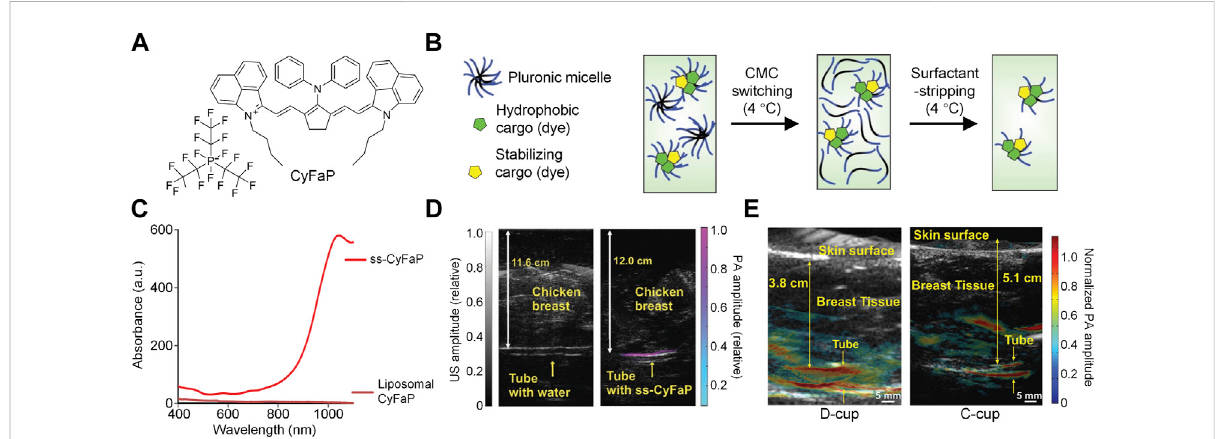
FIGURE 2 (A) Chemical structure of CyFaP. (B) Schematic illustration of preparation of surfactant-stripped micelles. (C) Absorption spectra of ss-CyFaP andLiposomal CyFaP. (D) PA overlaid with ultrasound images oftube with water orss-CyFaP. (E) PAoverlaidwith ultrasoundimagesof tubewith ss- CyFaP under the breast of adult female volunteers. Adapted from (Chitgupi et al., 2019). Copyright © 2019 Wiley-VCH Verlag GmbH & Co. KGaA,